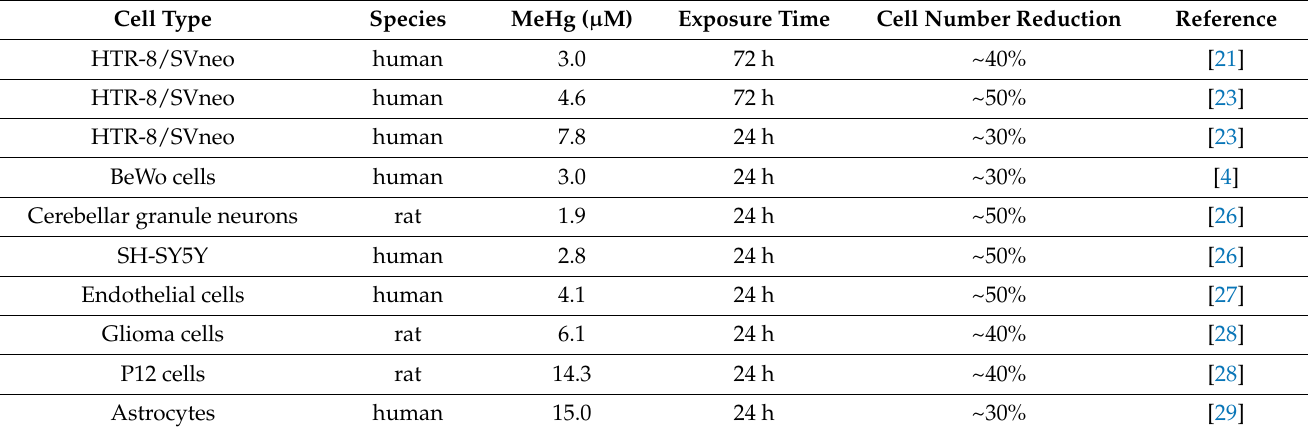
Table 1. Reduction of cell number after MeHg treatment in different cell